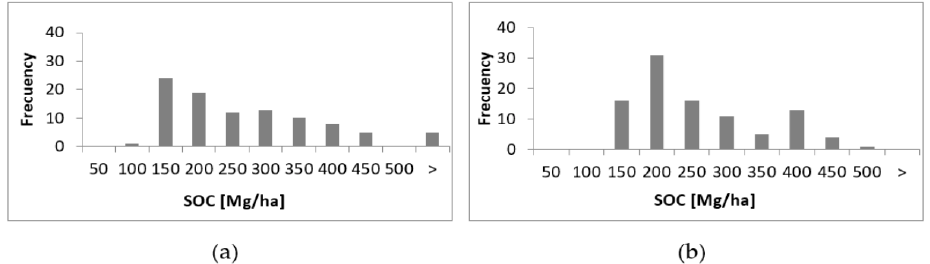
Figure 3. General distribution model of SOC in the Atillo river lake system: ( a ) 0–30 cm profile; ( b ) 30–60 cm profile. The confidence level is